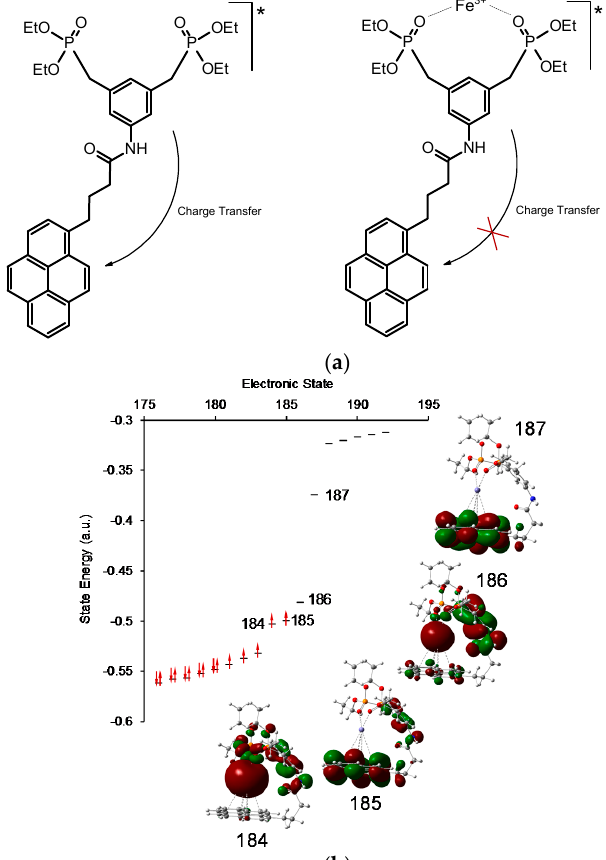
Figure 4. ( a ) Schematic representation of the fluorophore emission of receptor 1 in the presence and absence of Fe 3+ cations, showing the excited state relaxation restriction in 1 + Fe 3+ complex; ( b ) The electronic structure of the 1 + Fe 3+ complex as calculated using UB3LYP/SDD and sextet spin multiplicity level of theory.